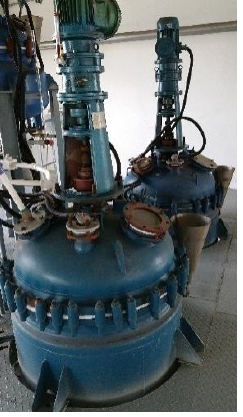
Figure 1. Plugging agent synthesis reactor.